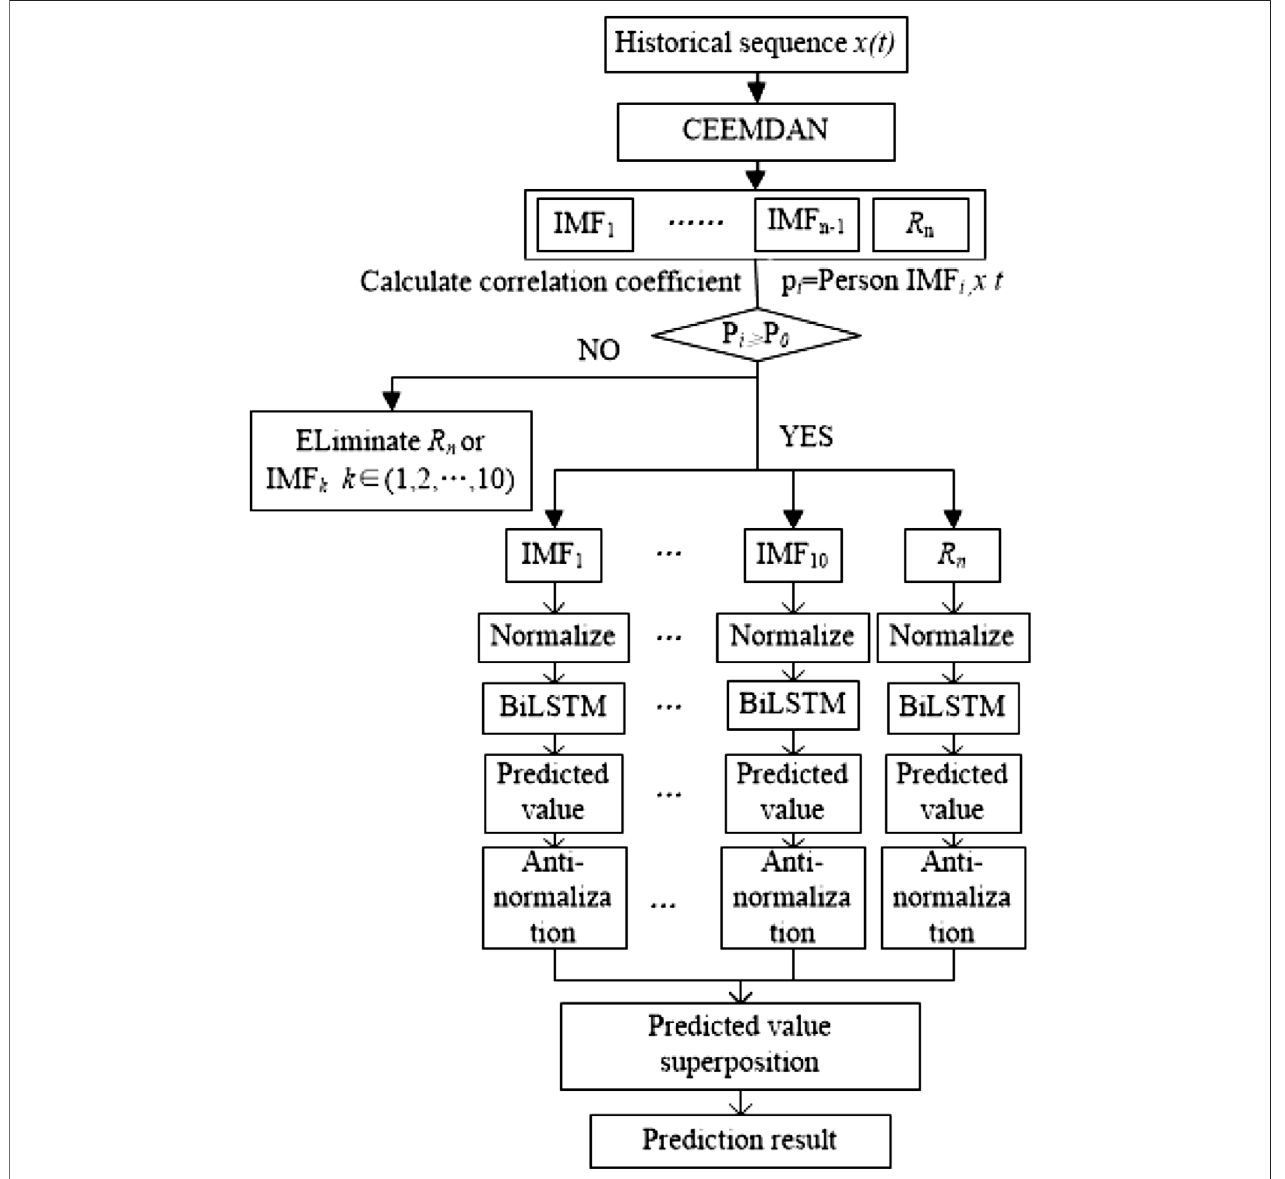
FIGURE 1 | CEEMDAN-BiLSTM model framework structure